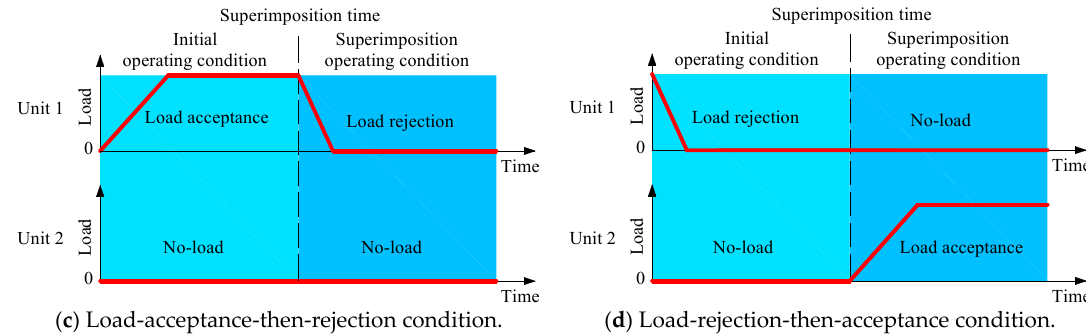
Figure 10. Four typical combined operating conditions [64].